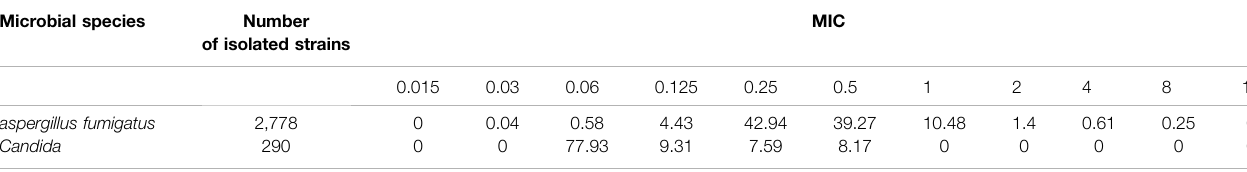
TABLE 1 | The frequency distribution of MIC values of voriconazole against Aspergillus fumigatus and Candida albicans (%). Microbial species Number of isolated strains